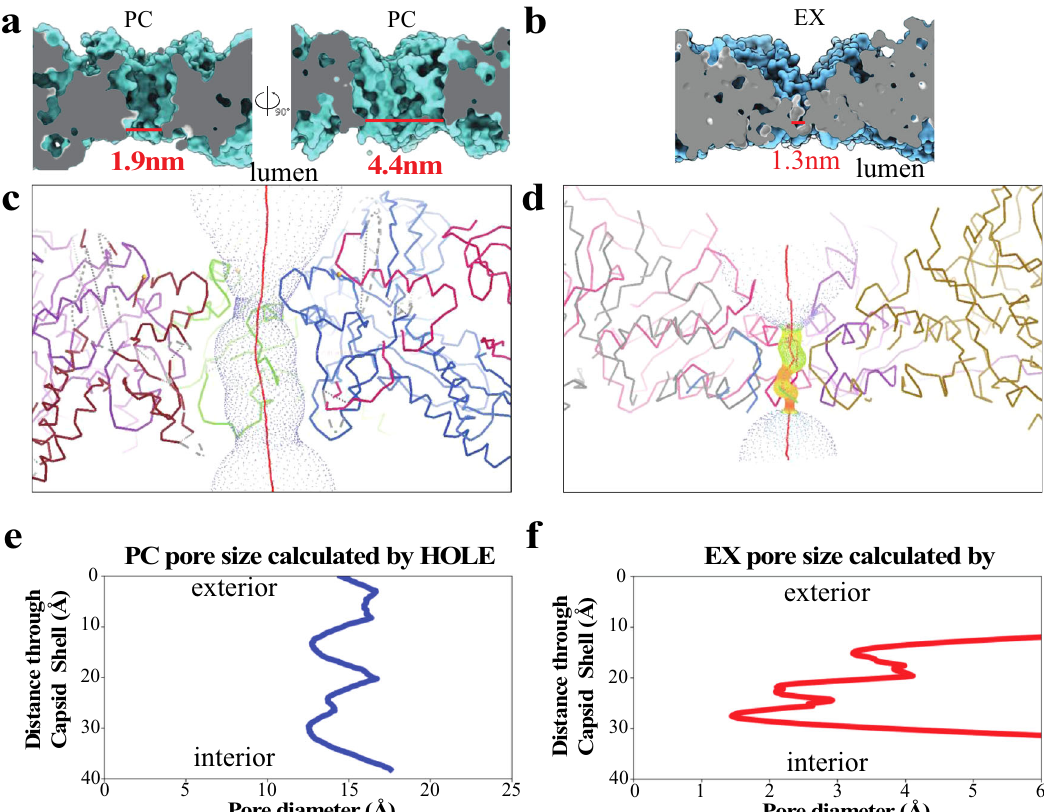
Fig. 4 Using HOLE to model P22 capsid pores for procapsid (PC) and expanded (EX) morphologies. a Image on the left is a model of the theoretical pore size of PC considering the electron density contribution of the amino acid side chains. Image on the left is the theoretical pore size of PC excluding the side chain electron density. b A model of the theoretical pore size of the EX capsids including side chain electron density. c , d Simulated path a sphere would travel when traversing across the P22 capsid shell for PC and EX morphologies, respectively. e , f A representation of distance traveled across the capsid shell as a function of pore